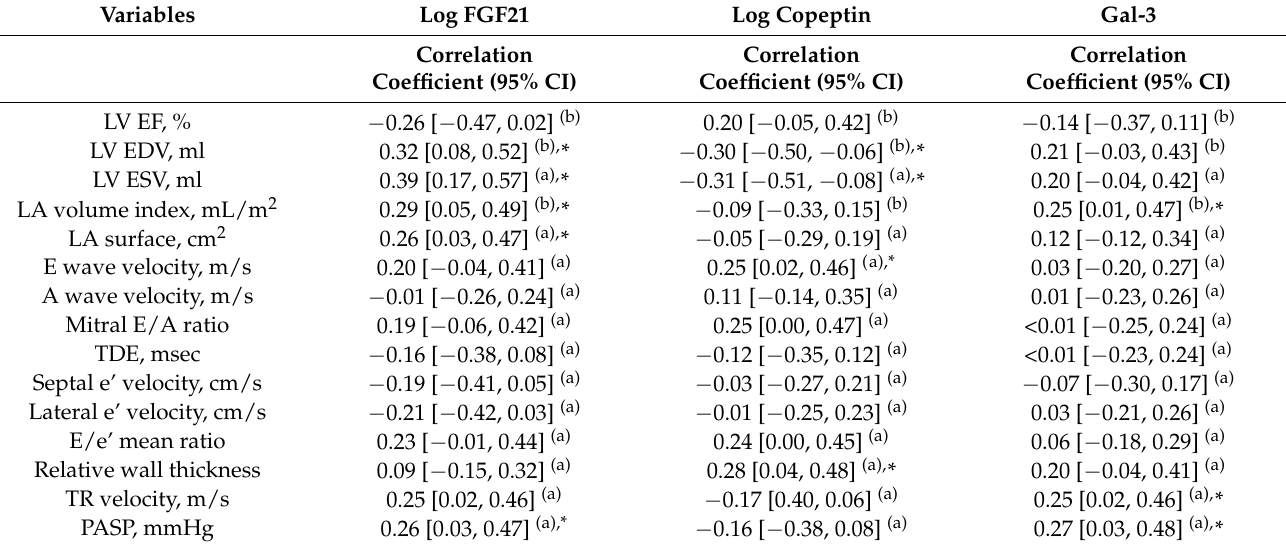
Table 4. Matrix of correlation coefficients (95% CI) between FGF21, galectin-3 and copeptin with echocardiographic